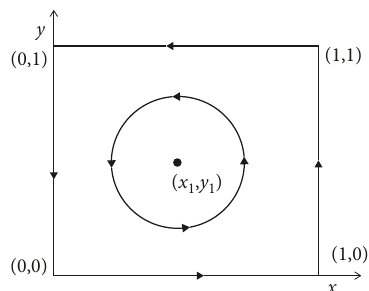
Figure 3: Replicated dynamic phase diagram of system 1 under condition